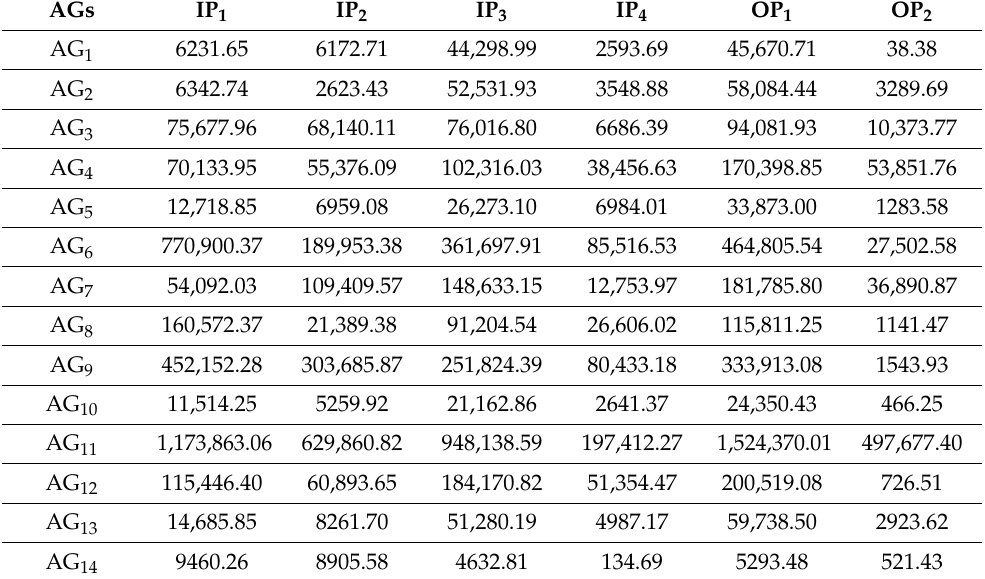
Table 12. Data in 2023 (Unit: 1000